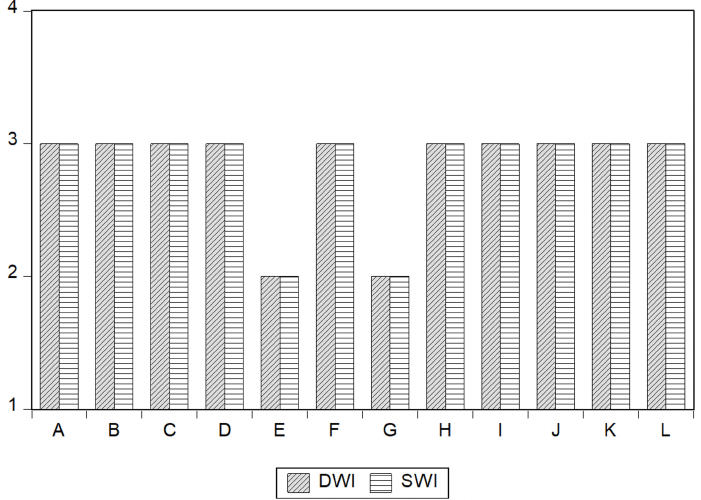
Figure 9. Degree of matching between the DWI / SWI and the field verification results. 3: matching; 2: partially matching; 1: mismatching. Table 4. Walking index values and their corresponding parameters in each field site. Model Calculation Field trip